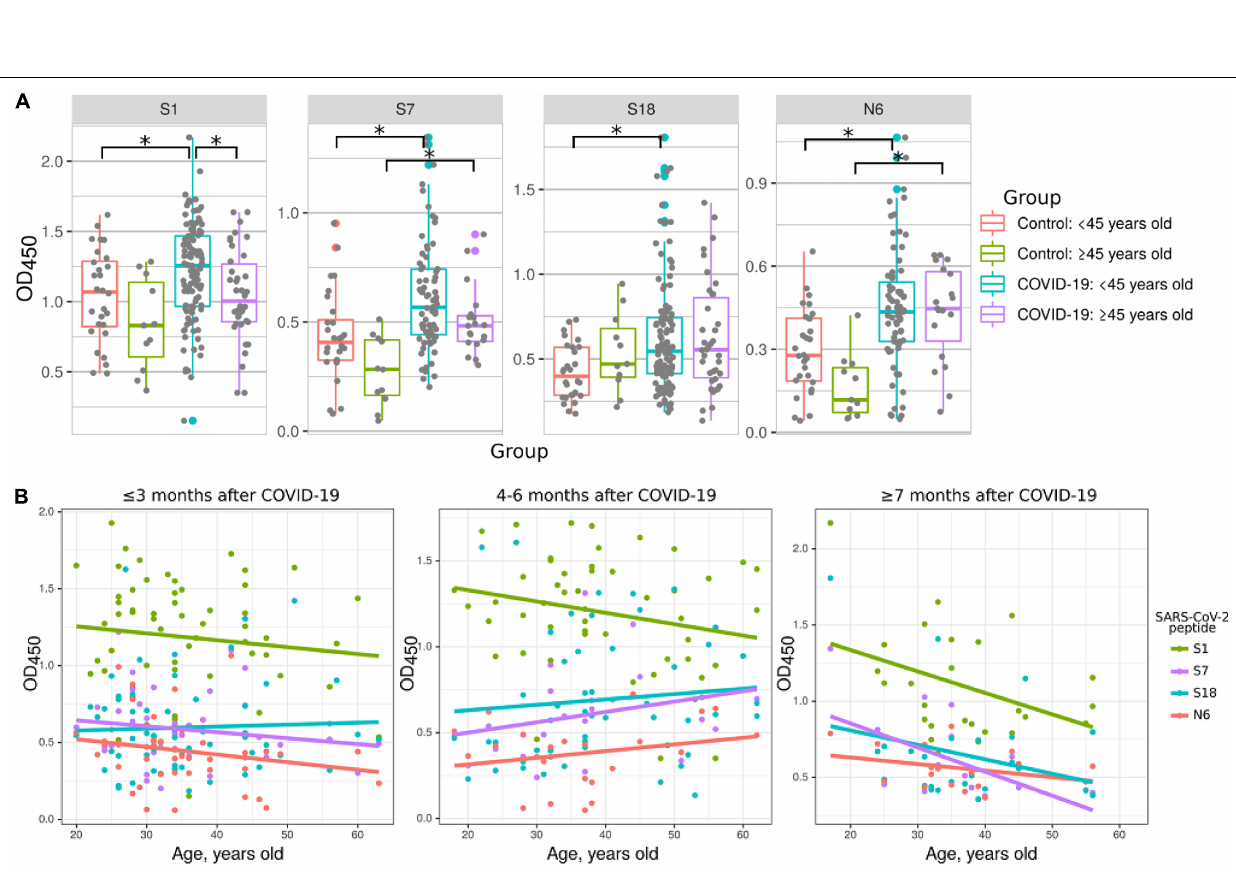
Frontiers in Microbiology |